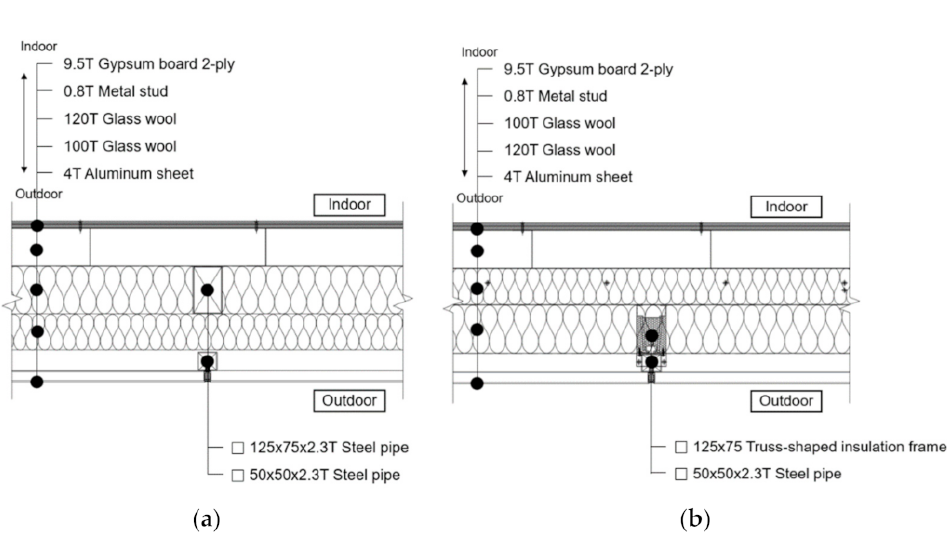
Figure 7. Horizontal sections of the simulation models: ( a ) base case; ( b ) alternative case.